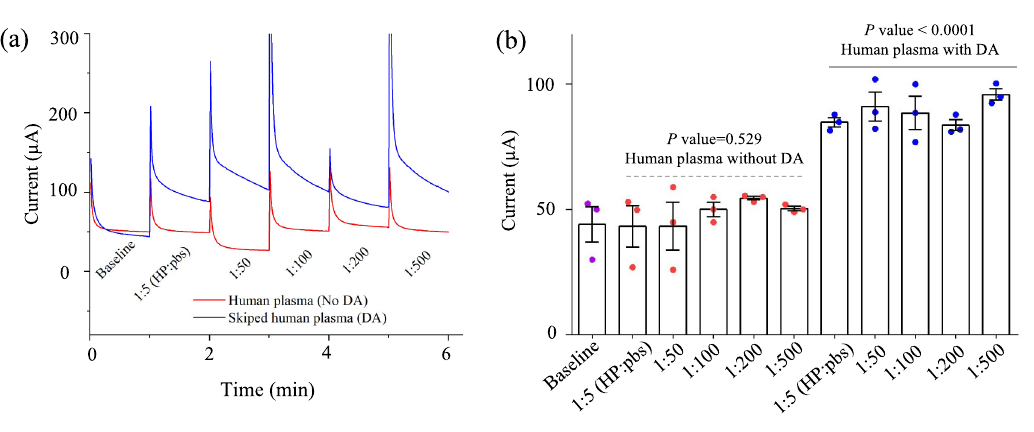
Fig. 6 3D Ag/rGO (10 × 10 array) Sensor for the detection of dopamine in human plasma. a Response of the 3D printed sensing platform developed in this work for the detection of dopamine in human plasma (HP). Human plasma was diluted in pbs solution in ratios of 1:5 to 1:500 (HP:pbs). The spiked human plasma was made by adding a fi xed dopamine concentration (1 p M ) into all the diluted plasma. The baseline measurement was carried out without adding any plasma or dopamine. b Plot showing the current response (at 60s) for the data in ( a ). Error bars in ( b ) are the standard error of the mean (s.e.m.) of measurements over at least n = 3 biologically independent experiments. Error bars, mean ± s.e.m. Statistical signi fi cance is determined by one- way ANOVA test (non-parametric) where p value is 0.529 ( p = 0.529) for human plasma without dopamine and <0.0001 ( p < 0.0001) for human plasma with dopamine, indicating dopamine detection in HP by the 3D sensor. p values for each comparison are labeled on top of the